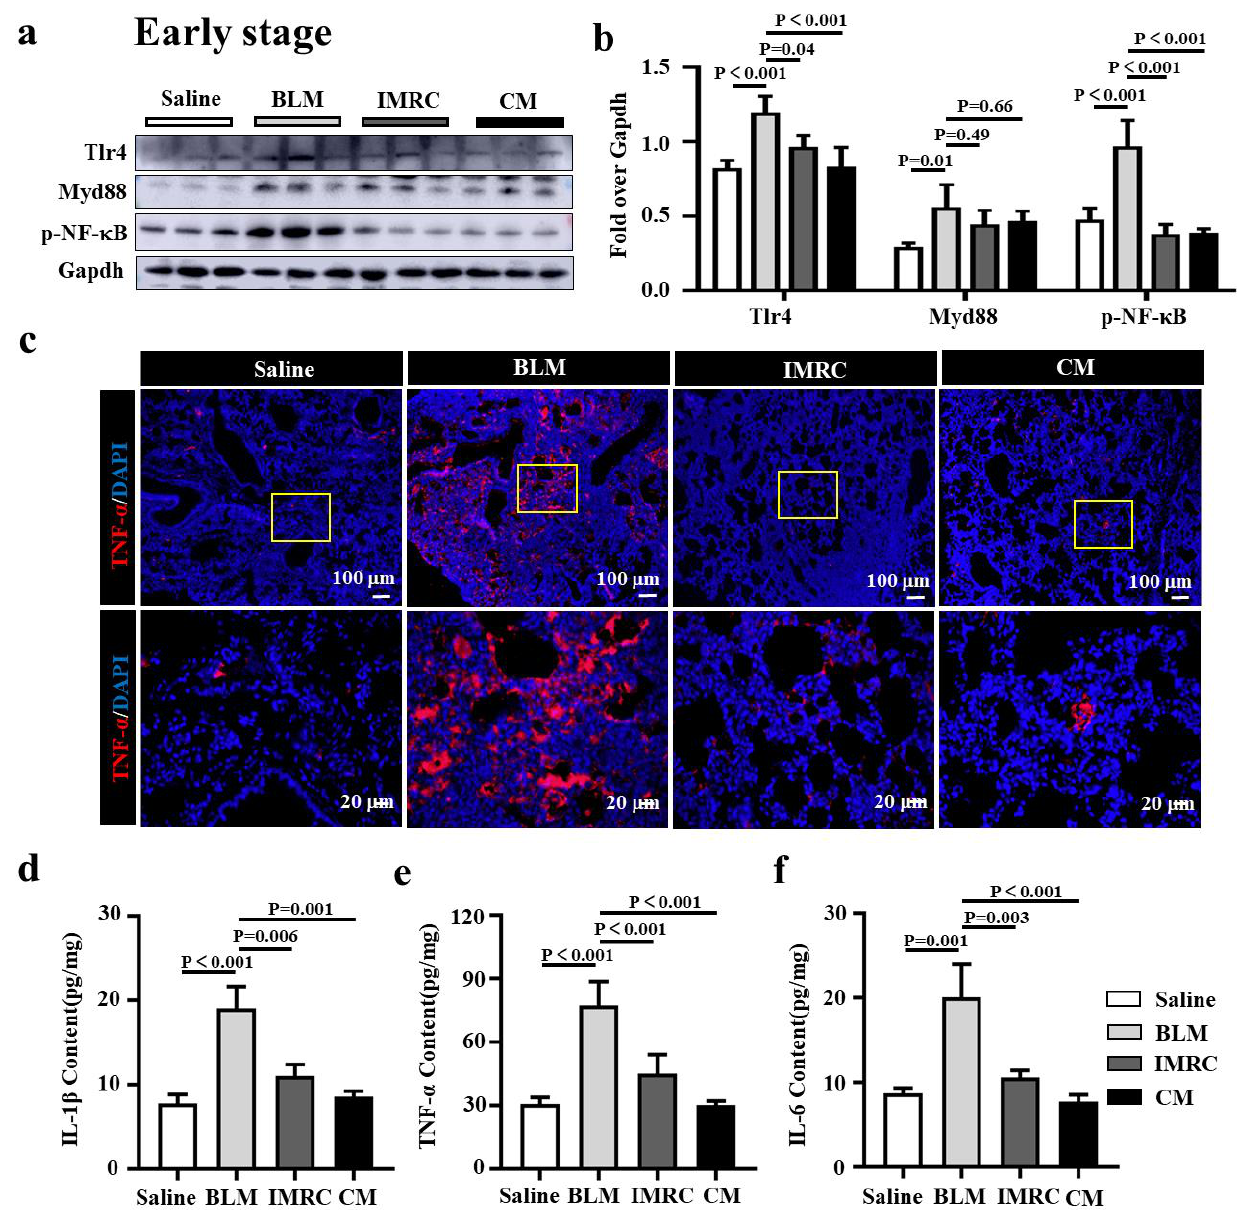
Figure 6. hESC-MSC-IMRCs and hESC-MSC-IMRC-CM ameliorate inflammation in mice in the development stage of PF. ( a ) Representative immunoblots showed a reduction of molecules in the Tlr4/MyD88 signaling cascade in BLM-induced lung treated with hESC-MSC-IMRC-CM or hESC- MSC-IMRCs at d3, d7, and d14 after the first dose of BLM challenge compared to the untreated BLM group. ( b ) The relative levels of Tlr4, MyD88, and p-NF- κB proteins as evaluated by a densitometric analysis in ( a ). ( c ) IF staining showed an increased abundance of TNF- α in BLM-induced pulmonary fibrosis compared to the saline group, but a decreased expression of TNF- α in the lungs of mice injected with hESC-MSC-IMRC-CM or hESC-MSC-IMRCs compared to the untreated BLM-injured mice. ( d – f ) the concentrations of TNF- α ( d ), IL-1 β ( e ), and IL-6 ( f ) proteins in lung homogenates in BLM-injured mice as determined by ELISA. Data in ( b , d – f ) represent mean ± SD of three independent experiments (N = 3), as analyzed by GraphPad prism two-way ANOVA Tukey’s multiple comparisons test. Scale bars in ( c ), 100 µm in the top panels, 20 µm in the bottom panels.